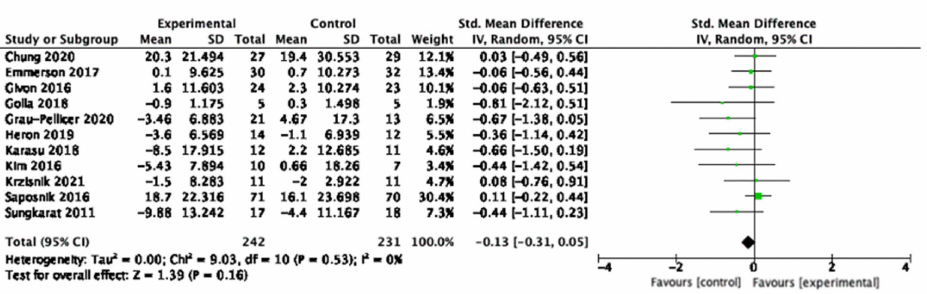
Figure 4. Meta-analysis results for sedentary behaviour.